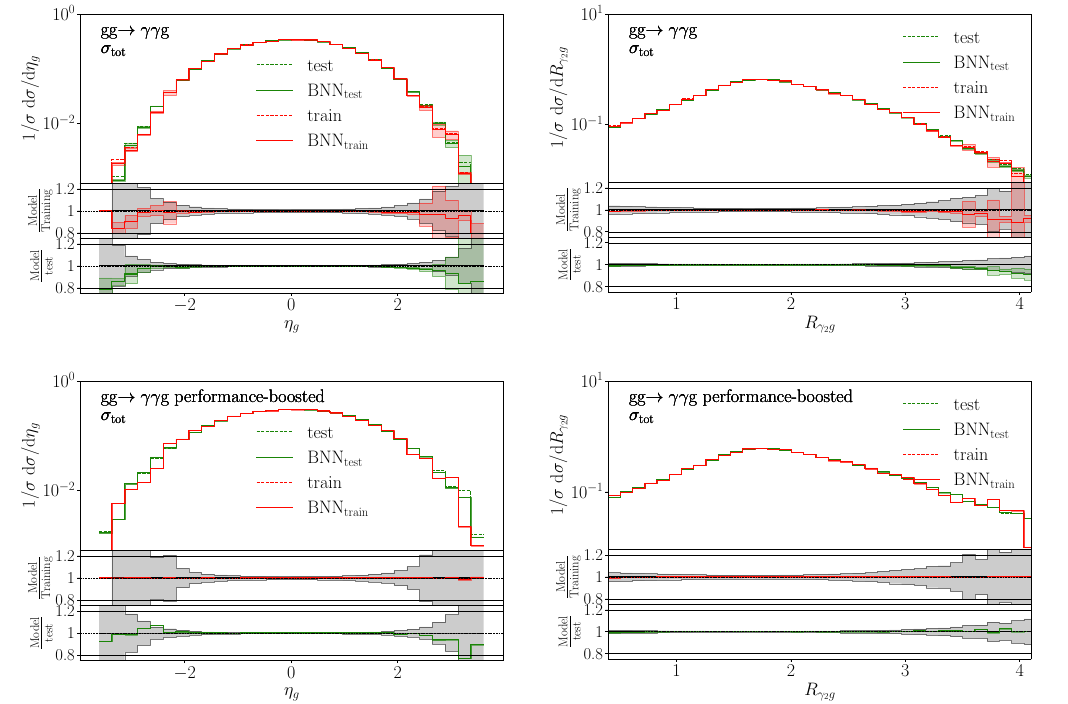
Figure 11: Kinematic distributions from the BNN without boosting (upper) and after performance-boosting (lower). The grey error bars in the lower panels indicate the statistical limitation of the training and test